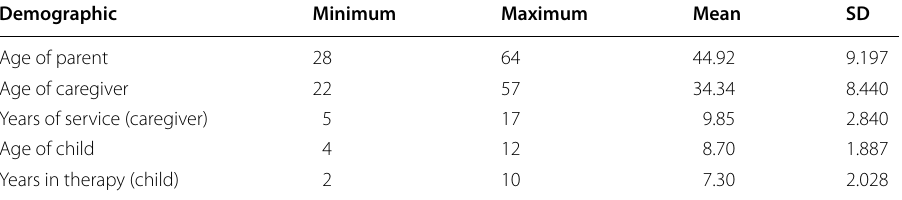
Table 2 Range, mean, and standard deviation for continuous demographic variables ( n